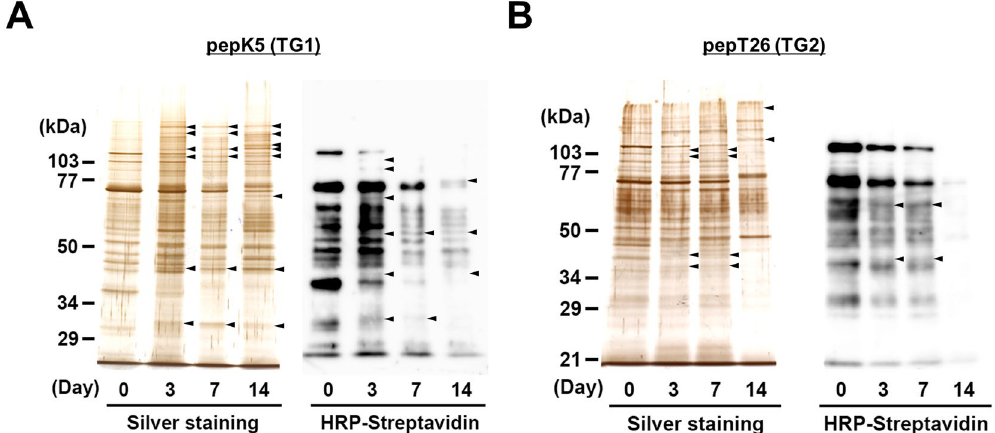
Figure 7. Detection of possible substrates incorporated with each peptide in kidney extracts. Each kidney extract on the indicated days after UUO surgery was incubated with the biotinylated pepK5 (for TG1; A ) and pepT26 (for TG2; B ). These biotinylated peptide-incorporated proteins after the purification using monoavidin gel were subjected to silver staining or detection using peroxidase-conjugated streptavidin. The sizes of the protein mass markers are shown on the left. Arrowheads indicate the bands that increased compared with the control sample (Day 0). Each experiment was done with more than three replicates from at least three independent